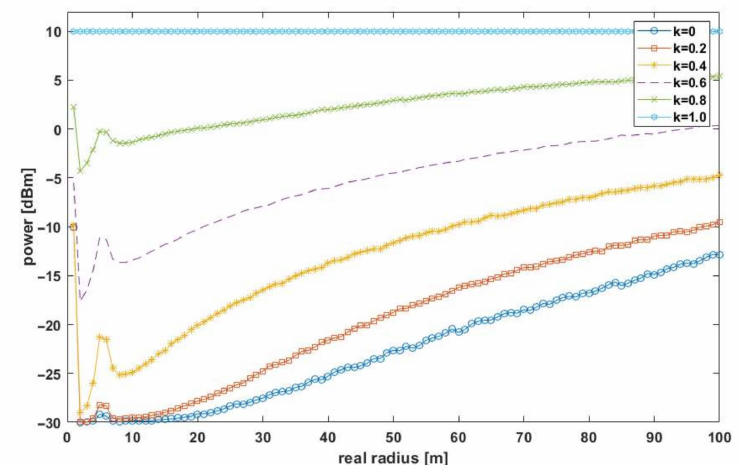
Figure 8. Transmitter power depending on the actual distance for different k -factor. The plot showed the resulting transmitter power determined by the running ATPC algorithm as a function of the actual distance between the sensors for two different values of the coefficient k . The stepped nature of the graph was due to a predefined set of transmitter power values that could be set in the CC110L chip register [33] ( − 30 dBm, − 20 dBm, − 15 dBm, − 10 dBm, − 6 dBm, 0 dBm, +5 dBm, +7 dBm, +10 dBm). This means that the resulting power value from the algorithm was rounded up to a settable value. In turn, Figure 9 shows the transmitter power values averaged from all simulations for different values of the coefficient k .